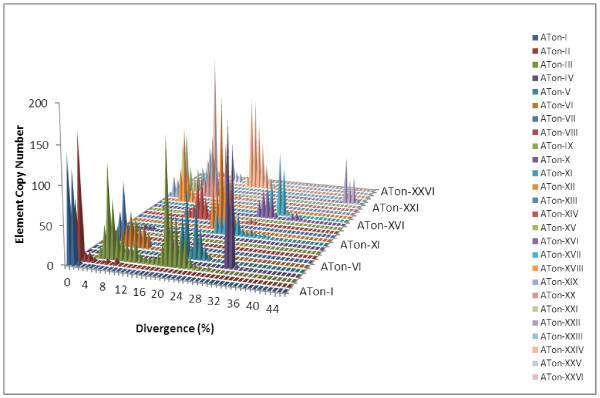
 Amplification of the 26 ATon elements inA.aegypti. The divergence of each copy form the consensus sequence is indicated on the x-axis while the copy number is indicated on the y-axis.